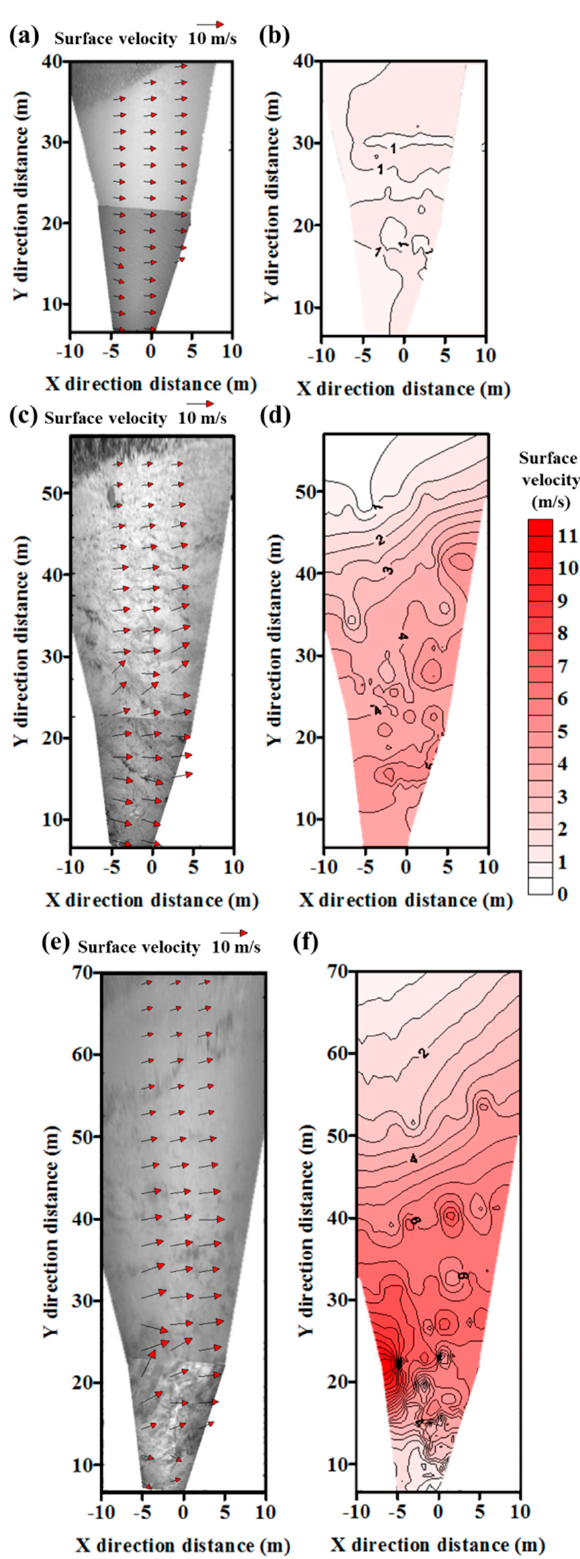
Figure 9. Measured surface velocity using LSPIV on 28 September 2015 (Typhoon Dujuan) ( a ) velocity vector at 08:00, ( b ) velocity contour at 08:00, ( c ) velocity vector at 12:00, ( d ) velocity contour at 12:00, ( e ) velocity vector at 17:00, and ( f ) velocity contour at 17:00.